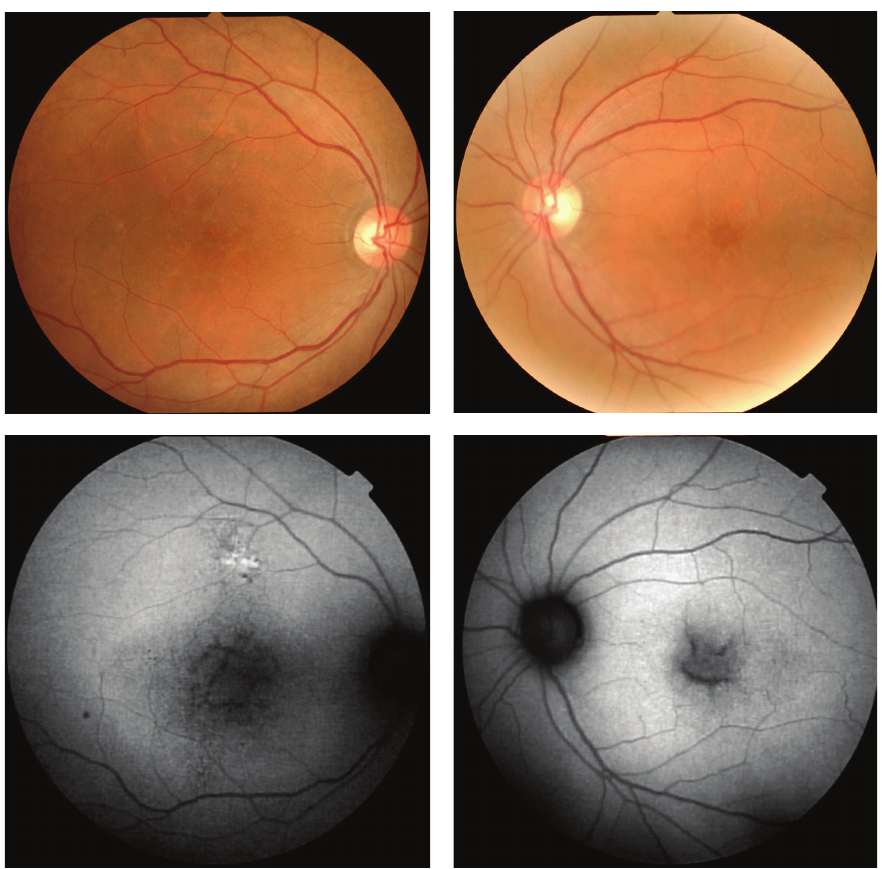
Figure 3: Fundus photographs and fundus autofluorescence (FAF) images of a patient with X-linked retinoschisis (XLRS). Fundus photographs show spoke wheel-like maculopathy in the left eye and central atrophy in the right eye. The FAF images show hypofluorescent areas in both